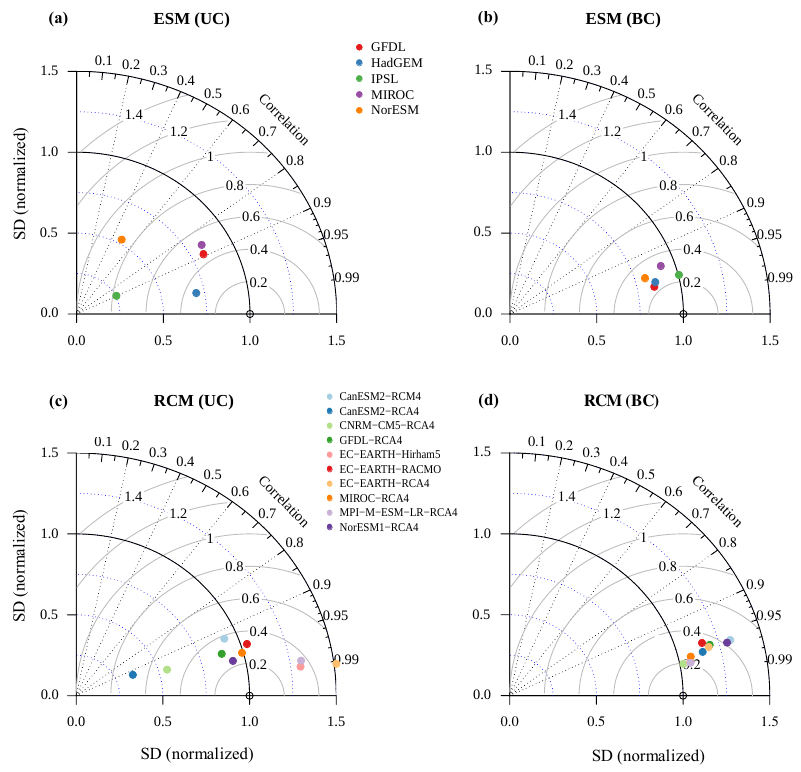
Figure 5. Taylor diagram of average daily discharges at gauge El Diem in the reference period (1970–1999). It shows R 2 , standard deviation (SD) normalized by SD ref , and normalized SD D of discrepancies for Earth system model (ESM) input in the top row and regional climate model (RCM) input in the bottom